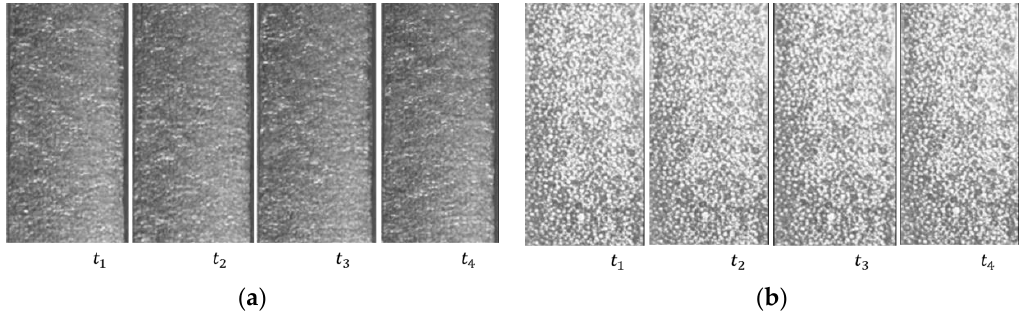
Figure 6. Flow patterns observed from the plain rectangular channel ( a ) and the copper porous media filled channel ( b ) at mean vapor quality are ( a ) = 0.87, ( b ) = 0.82.